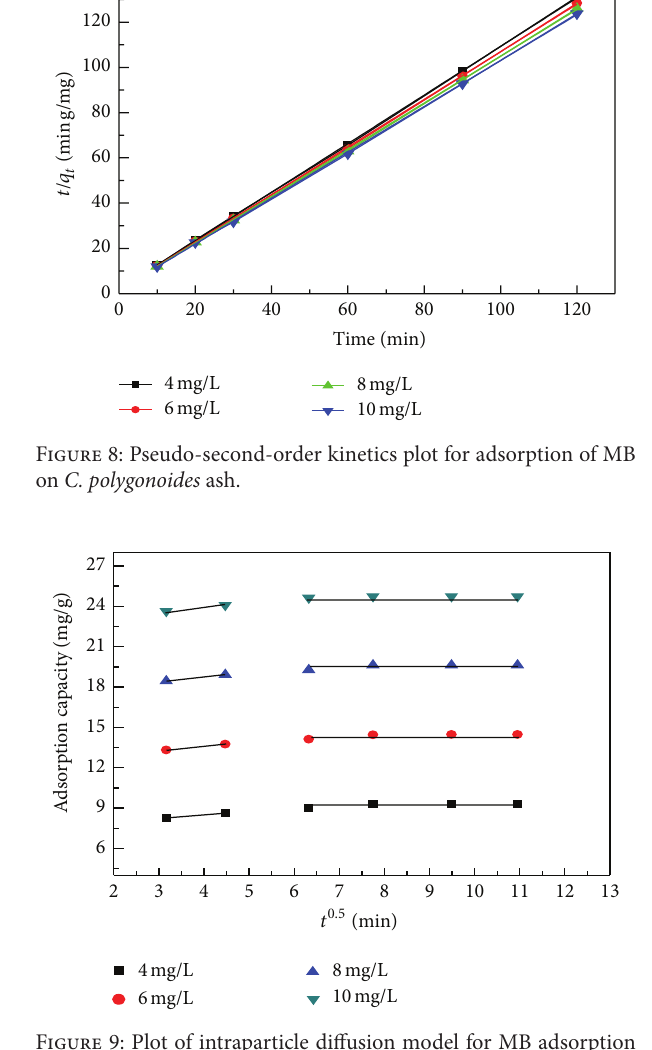
Figure 9: Plot of intraparticle diffusion model for MB adsorption by C. polygonoides ash at different initial dye